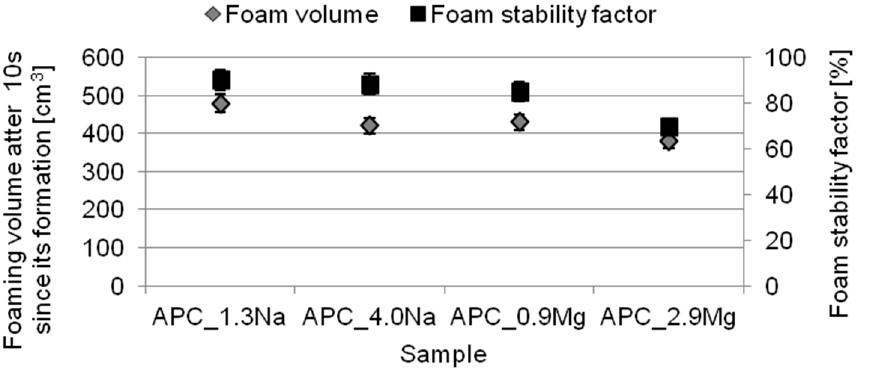
Figure 6. Foam properties of